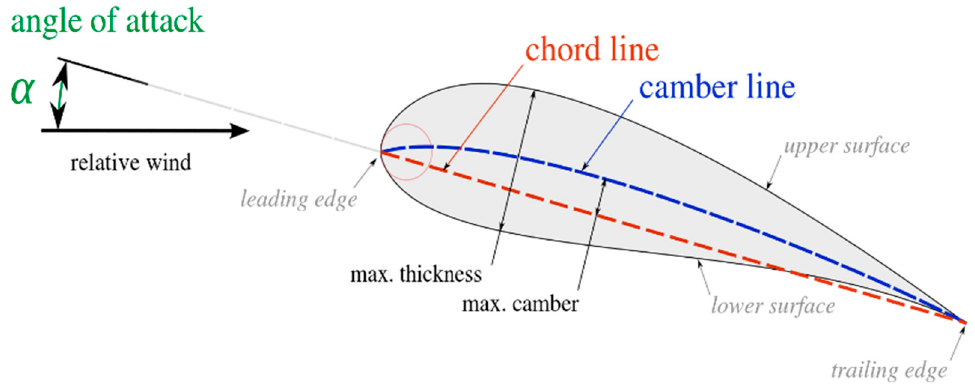
Figure 2. Basic concept of an airfoil [13]. Energies 2020 , 13 , x FOR PEER REVIEW